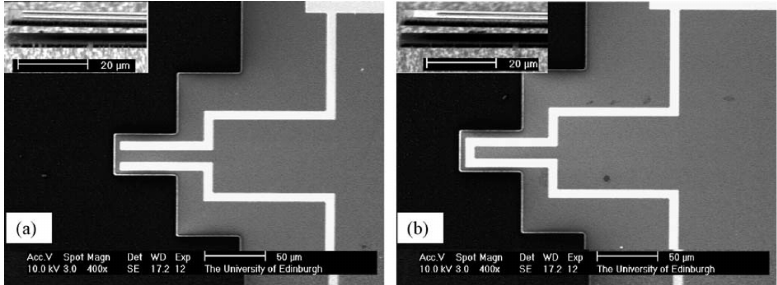
Figure 11. SEM images of 3C-SiC cantilevers with NiCr electrodes for ( a ) open-termination and ( b ) closed termination design [26]. Reprinted from Sens. Act. A: Phys., 128, Jiang et al., SiC cantilever resonators with electrothermal actuation, 376–386, c (cid:13) 2006, with permission from